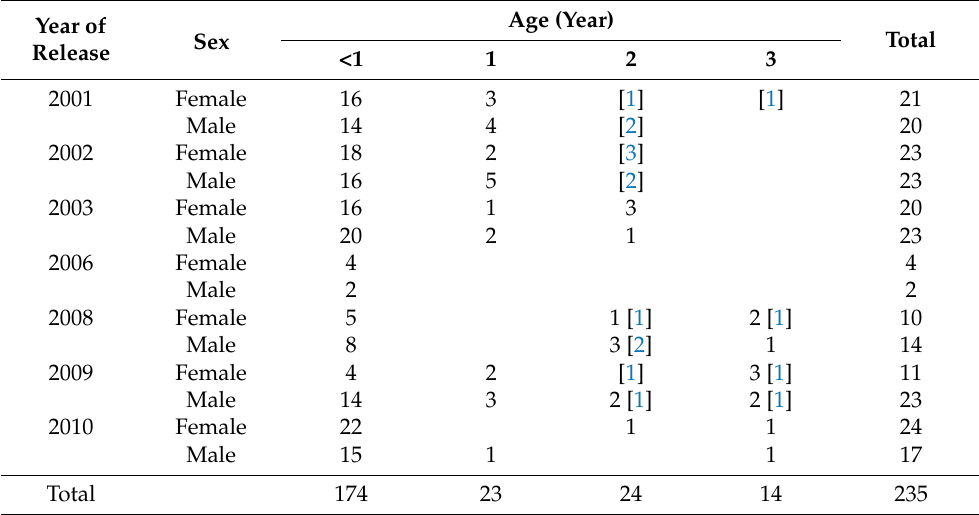
Table 2. Summary of released Parantechinus apicalis to Peniup Nature Reserve between 2001 and 2010. Brackets indicate numbers of founders that were released after contributing offspring to the captive